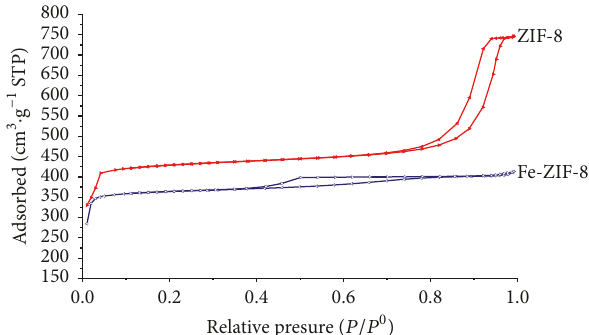
Figure 4: Nitrogen adsorption/desorption isotherms of ZIF-8 and